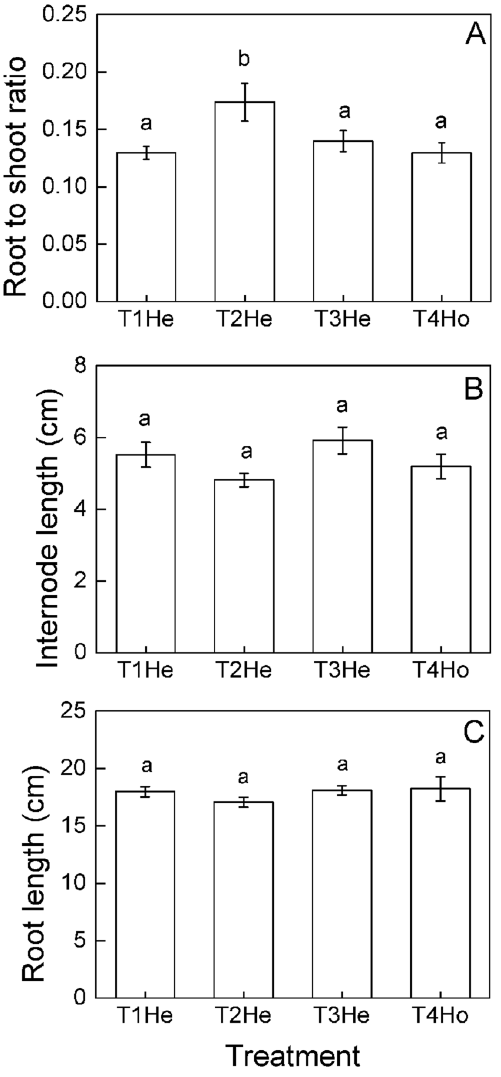
Figure 7. Different responses of root to shoot ratio and morphological characters of Buchloedactyloides among hetero- geneous patches of different nutrient treatments at clonal fragment level. Mean values ( 6 S. E.) of root to shoot ratio (A), internode length (B) and root length (C) are given. Bars sharing the same letters are not different at p =0.05. Treatment codes are in Figure